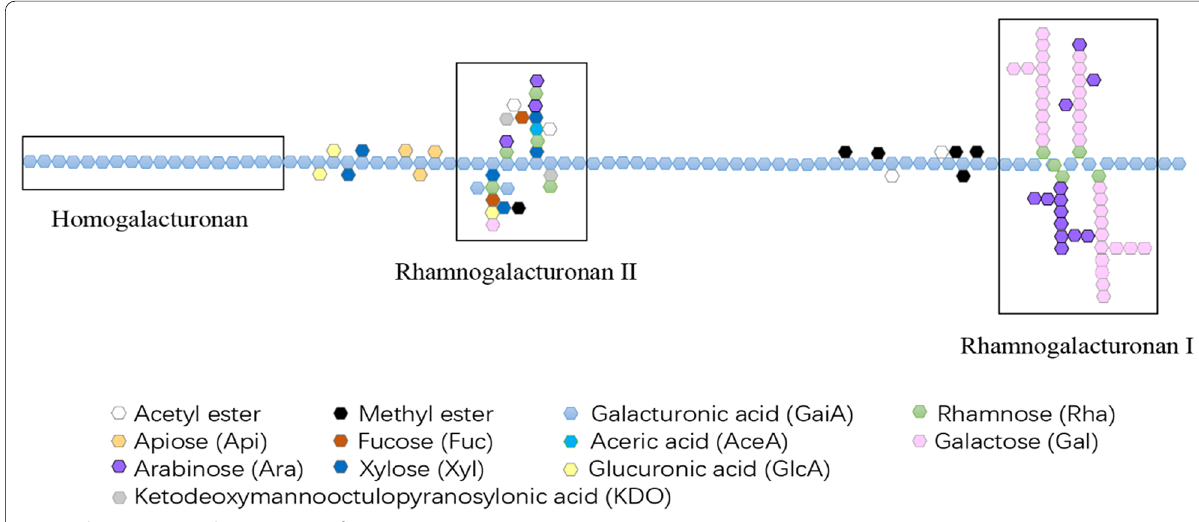
Fig. 1 The structure and composition of pectin